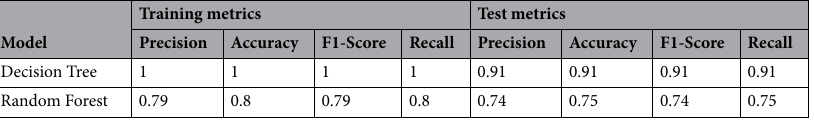
Table 5. Different ML models training and test performance metrics.